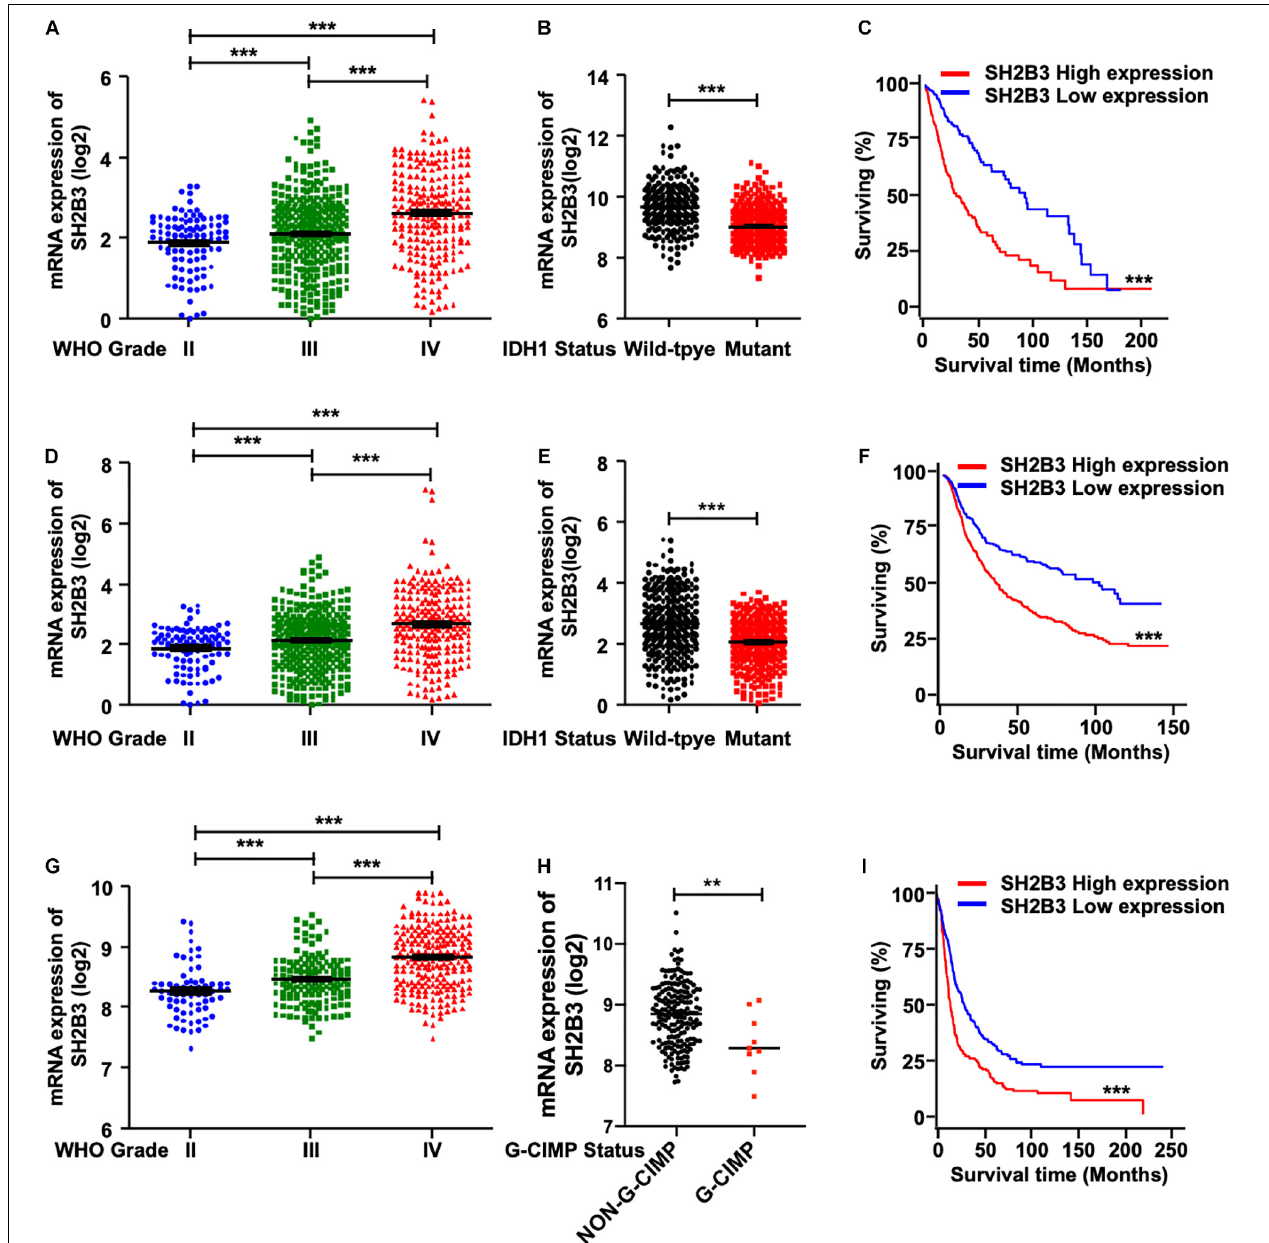
FIGURE 1 | SH2B3 expression is elevated in glioblastoma. (A) SH2B3 expression in different grades of gliomas in the TCGA data set. (B) SH2B3 expression in the IDH1 WT and mutant groups was analyzed in the TCGA data set. (C) The correlation of SH2B3 expression and its corresponding glioma patient’s survival in the TCGA data set were analyzed. Survival analysis was evaluated using the Kaplan–Meier method and assessed using the log-rank test. (D) SH2B3 expression in different grades of gliomas in the CGGA data set. (E) SH2B3 expression in the IDH1 WT and mutant groups was analyzed in the CGGA data set. (F) The correlation of SH2B3 expression and its corresponding glioma patient’s survival in the CGGA data set were analyzed. Survival analysis was evaluated using the Kaplan–Meier method and assessed using the log-rank test. (G) SH2B3 expression in different grade gliomas in Rembrandt data set. (H) SH2B3 expression in the G-CIMP and non-G-CIMP groups was analyzed in Rembrandt data set. (I) The correlation of SH2B3 expression and its corresponding glioma patient’s survival in Rembrandt data set were analyzed. Survival analysis was evaluated using the Kaplan–Meier method and assessed using the log-rank test. *, **, and *** indicate p < 0.05, p < 0.01, and p < 0.0001,